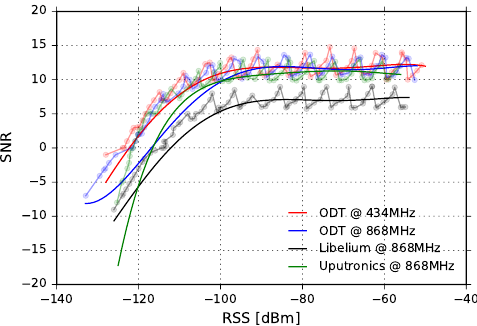
Figure 8. Signal-to-Noise ratio vs. Received signal strength for ODT (434MHz), ODT ((868MHz), Libelium (868MHz) and Uputronics